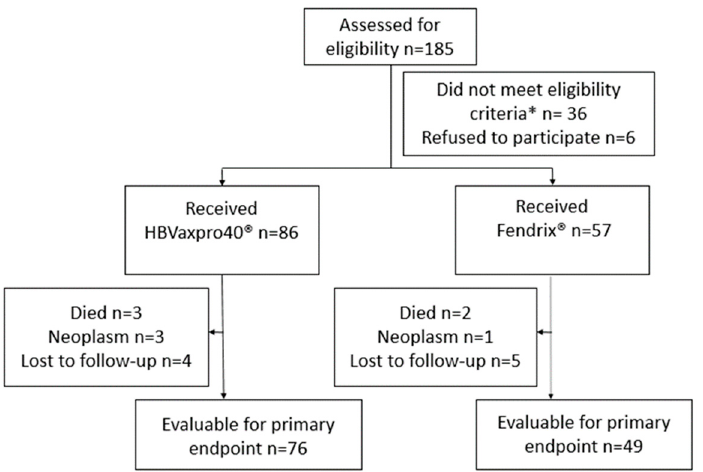
Figure 2. Flowchart of the study. * Patients previously vaccinated against HBV n = 10, Anti-HBs positive/anti-HBc negative n = 6, Anti-HBc positive/anti-HBs negative n = 9, Nonimmunized HAV infection n = 6, active neoplasia n = 2, Child–Pugh C n =